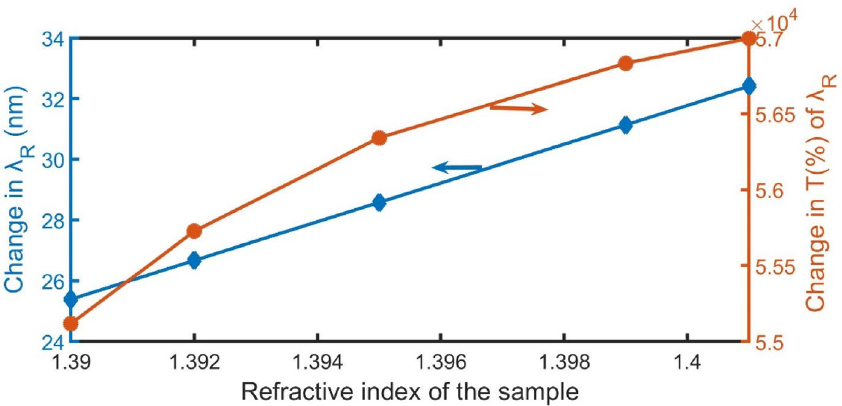
Figure 8. The position shift of the resonant peak and its transmittance versus the change in the refractive indices of samples.